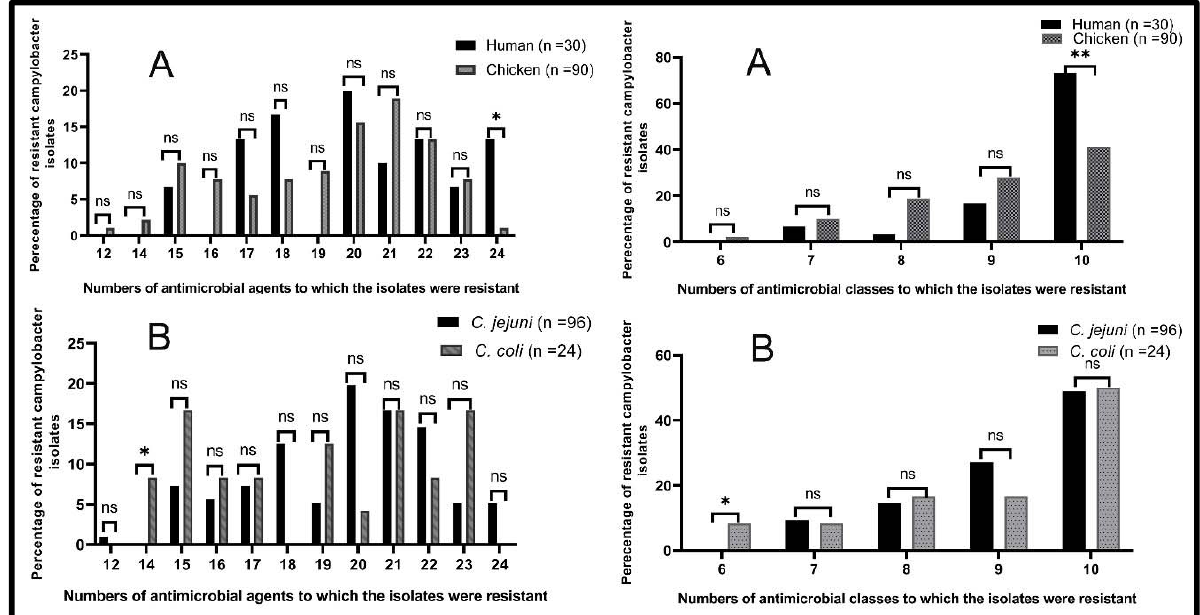
Figure 3. Antimicrobial resistance patterns of human and chicken Campylobacter isolates ( A ) and C. jejuni and C. coli ( B ). n : number, ns: non-significant, * p < 0.05, ** p < 0.01.